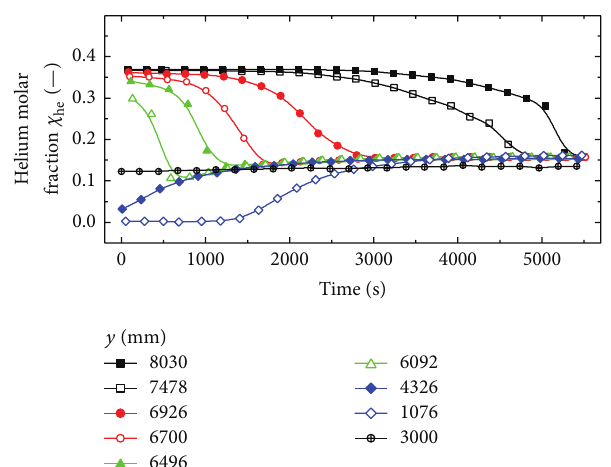
Figure 14: Helium molar fraction measured for selected locations in the jet axis ( 𝑥 = −650 mm) as a function of time with the vertical measurement location as parameter. The molar fraction at the tube exit is provided at 𝑦 = 3000